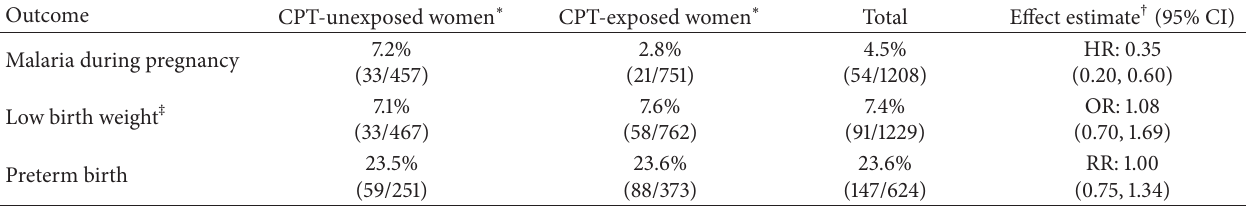
Table 2: Frequency of outcomes of interest and effect estimates in CPT-exposed and CPT-unexposed pregnant women.